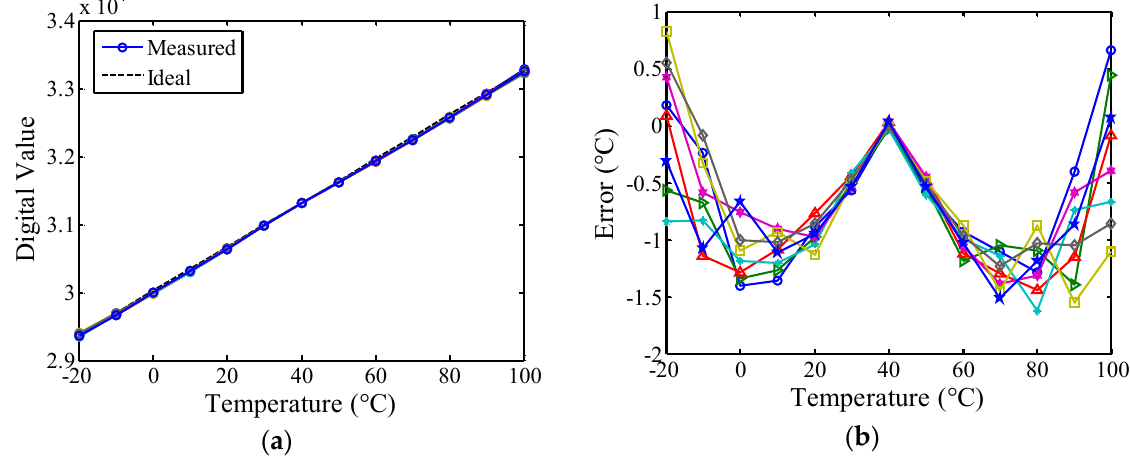
Figure 14. ( a ) Measured transfer curves of the N'(T) for eight FPGA chips after linearization and ideal curve for comparison; ( b ) Inaccuracies of the linearized sensor for eight FPGA chips. Table 1. Measured performances of the three versions for easy comparison.